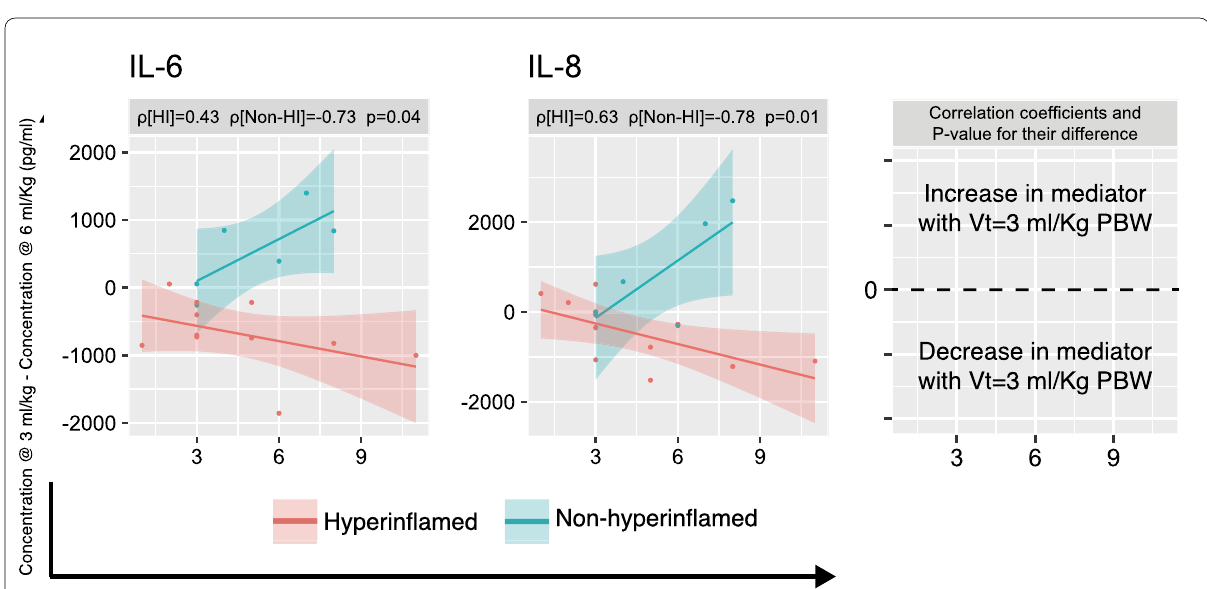
Fig. 4 Correlation between the change in IL‑6 and IL‑8 BALF levels from ventilation with 6 ml/kg predicted body weight (PBW) to 3 ml/kg PBW and the corresponding change in driving pressure in hyperinflamed and non‑hyperinflamed patients (defined using a threshold in IL‑6 levels during ventilation with 6 ml/kg PBW of 680 pg/ml). Note that the x ‑axis represents the change in driving pressure when tidal volume is decreased, which is mainly defined by compliance of the respiratory system. IL interleukin. P values correspond to the comparison between the two